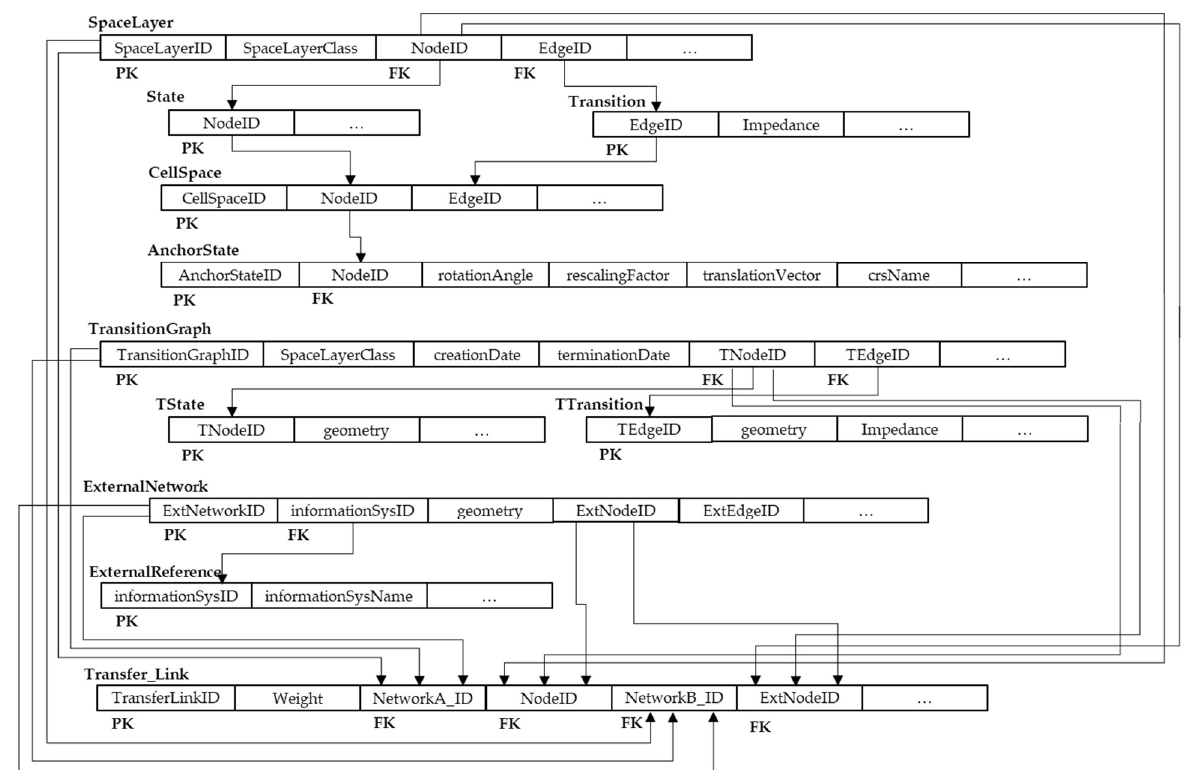
Figure 9. A sample DB schema for the proposed model.